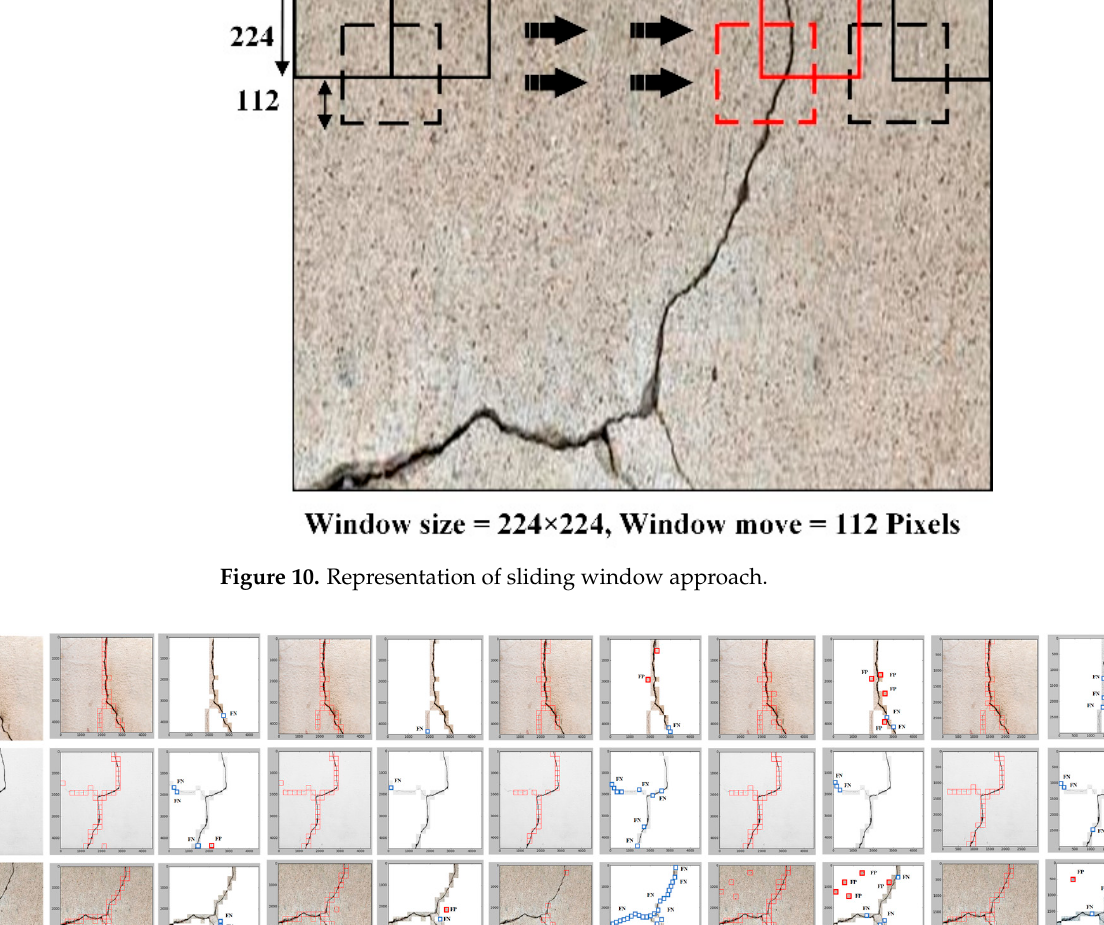
Figure 11. ( a ) Original images. ( b ) Crack localization using VGG-16. ( c ) Screening for false positives (FP) and false nega- tives (FN) using VGG-16. ( d ) Crack Localization using VGG-19. ( e ) Screening for FP and FN using VGG-19. ( f ) Crack